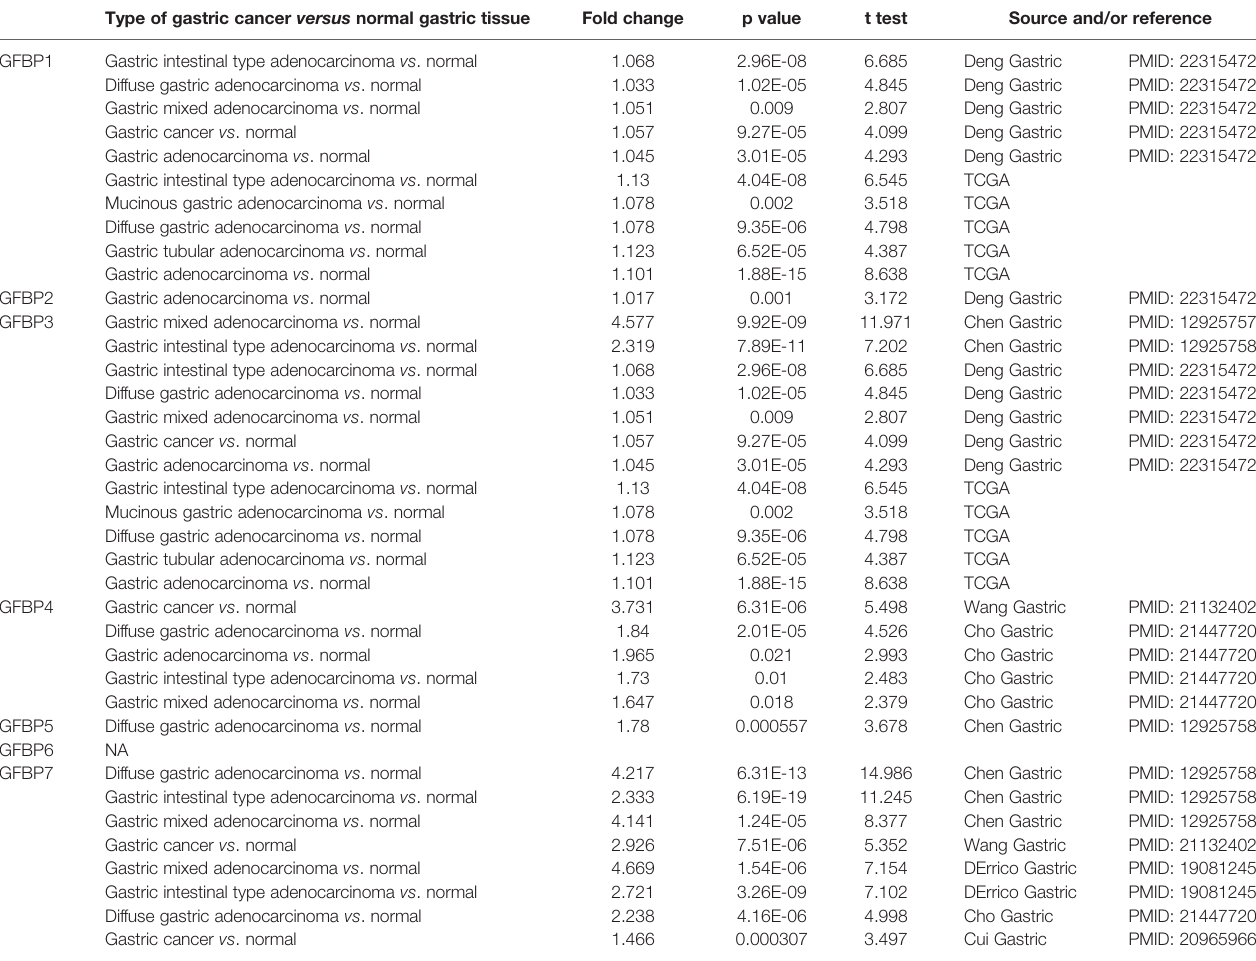
TABLE 1 | IGFBP1 – 7 expression in STAD patients from the cBioPortal database. Type of gastric cancer versus normal gastric